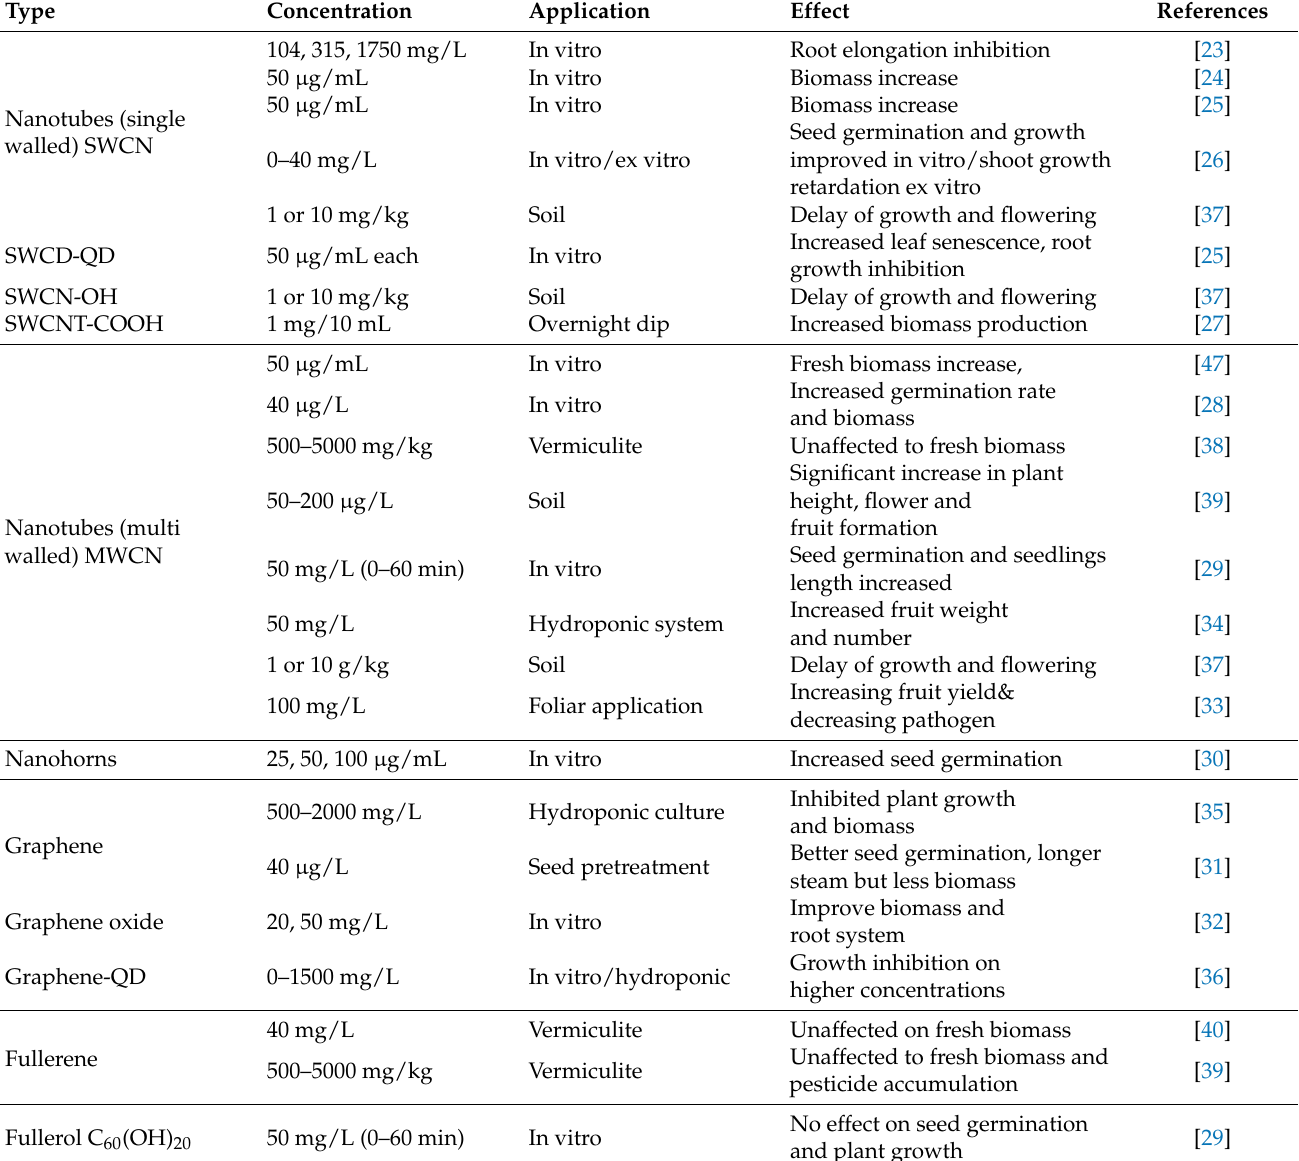
Table 1. The effect of carbon nanoparticles on tomato growth and